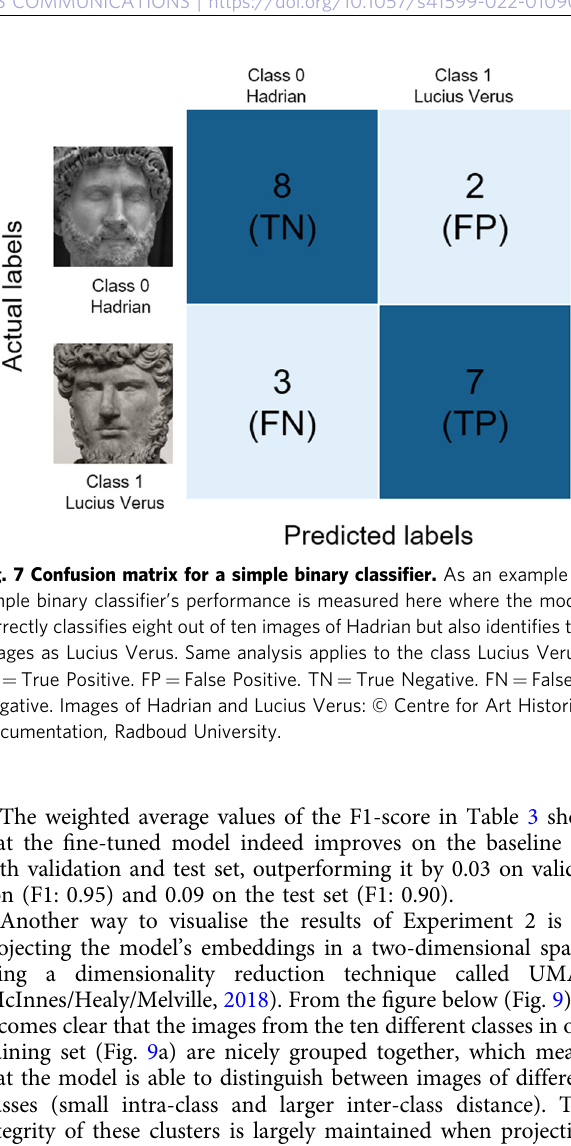
matrix for a simple binary classi fi er model is shown in the Fig. 7. the correct predictions — i.e., True Positives (TP) and True Negatives (TN) — while the non-diagonal elements represent false positives (FP) and false negatives (FN).